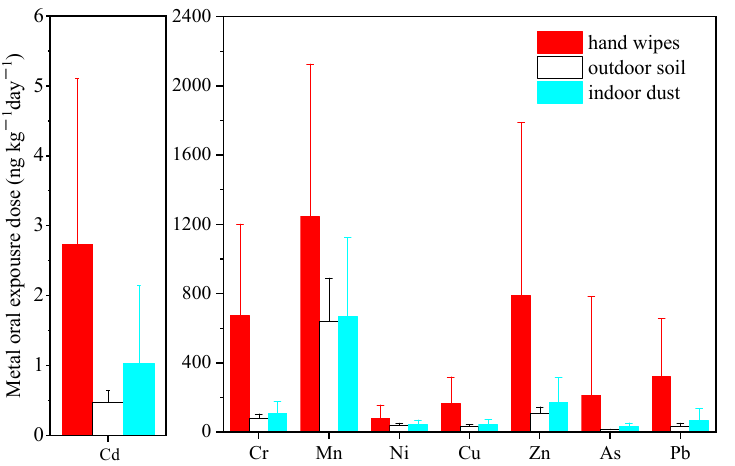
Figure 2. Comparison of metal oral exposure dose via hand wipes, outdoor soil and indoor dust.